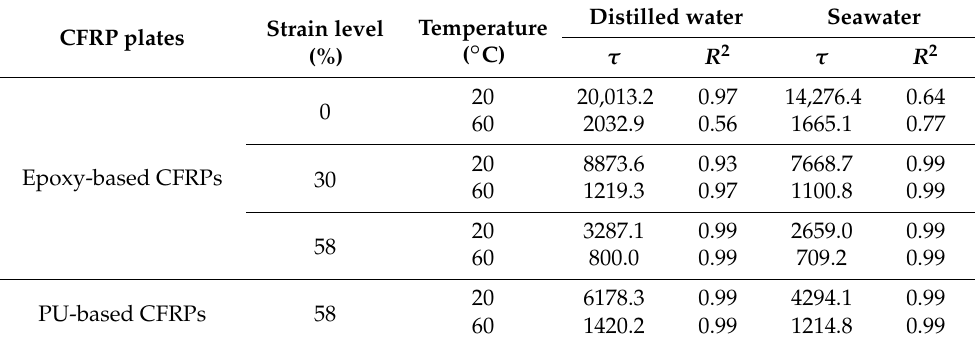
Table 3. Coefficients of regression equation in Equation